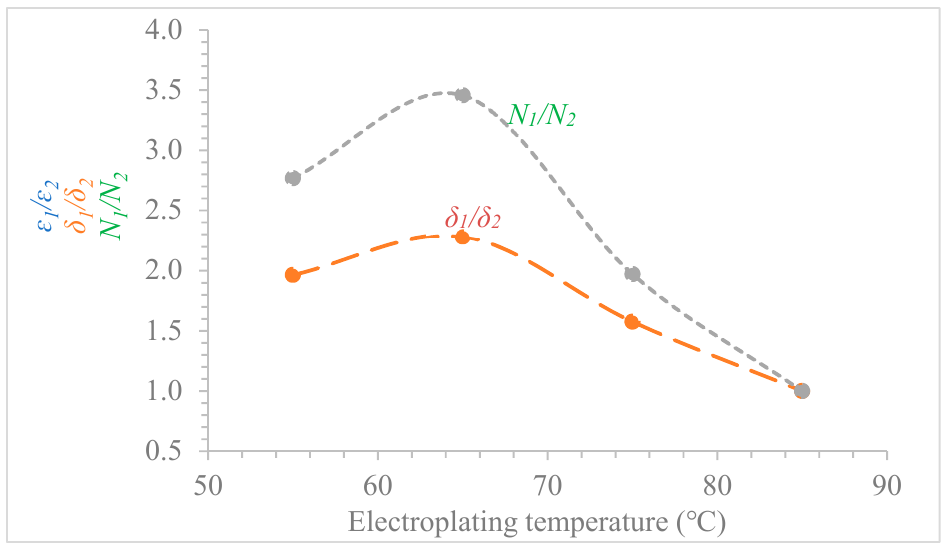
Figure 4. Comparative analysis of the dislocation density and number of crystallites per unit area of the CdTe films electroplated at different cathodic voltages.